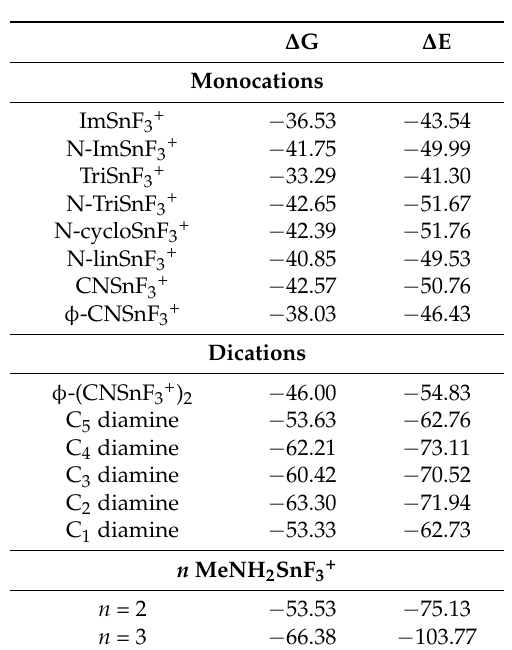
Figure 2. Geometries of indicated Lewis acids with Cl − . Distances in Å, angles in degs. Table 4. Energetics (kcal/mol) for interactions between Cl − and indicated receptors.